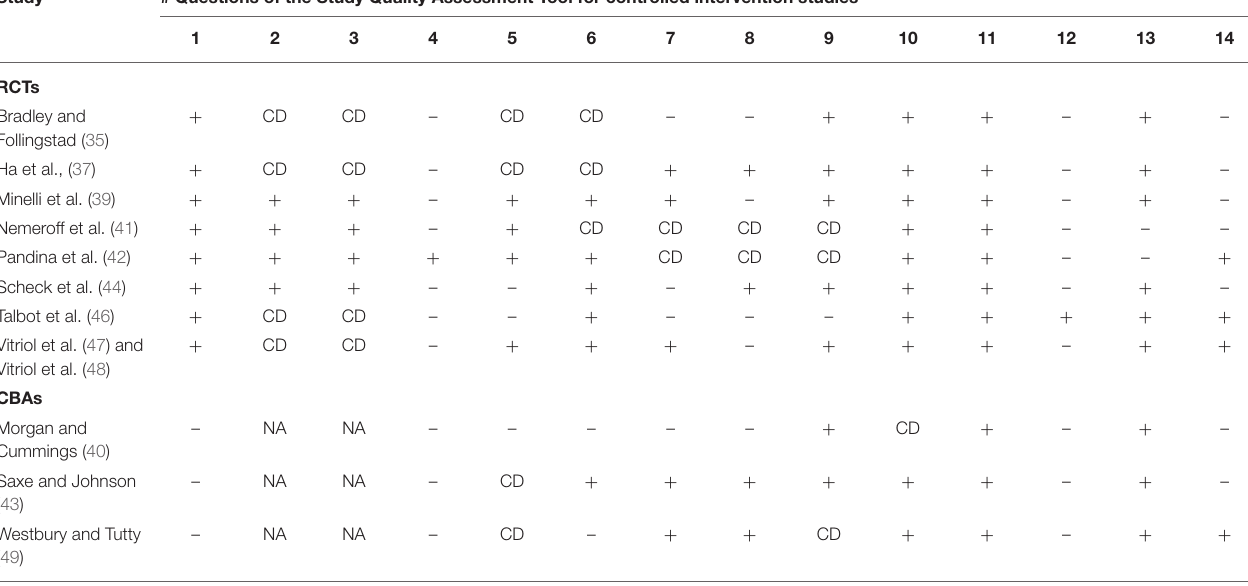
TABLE 3 | Critical appraisal for controlled intervention studies. Study